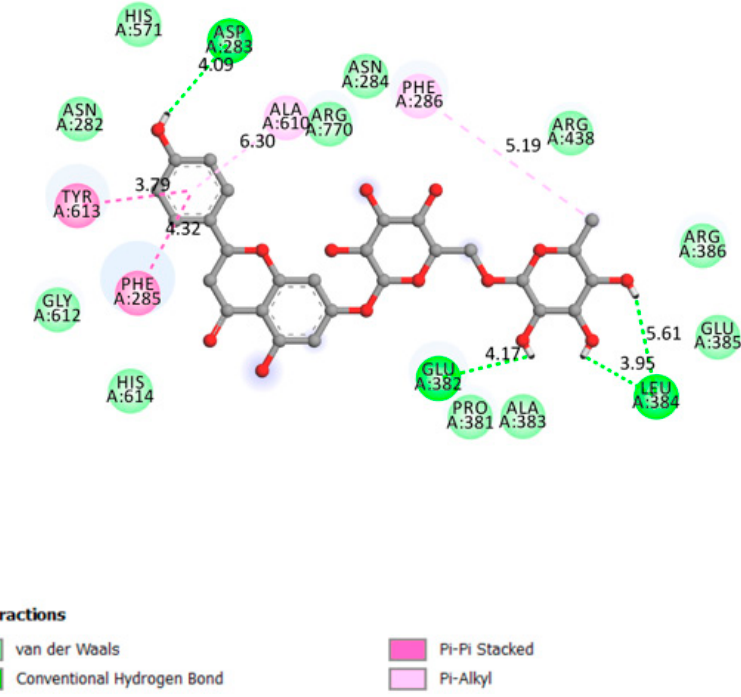
Figure 8. Two-dimensional scheme of the narirutin interactions with Glycogen Phosphorylase